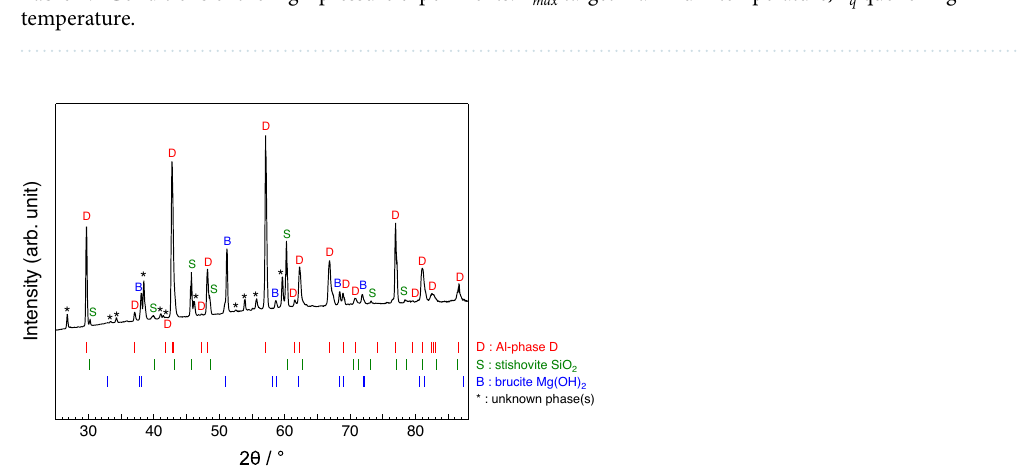
Figure 1. Microfocus powder X-ray diffraction pattern of a recovered sample. As an example, that of the run #2 is given